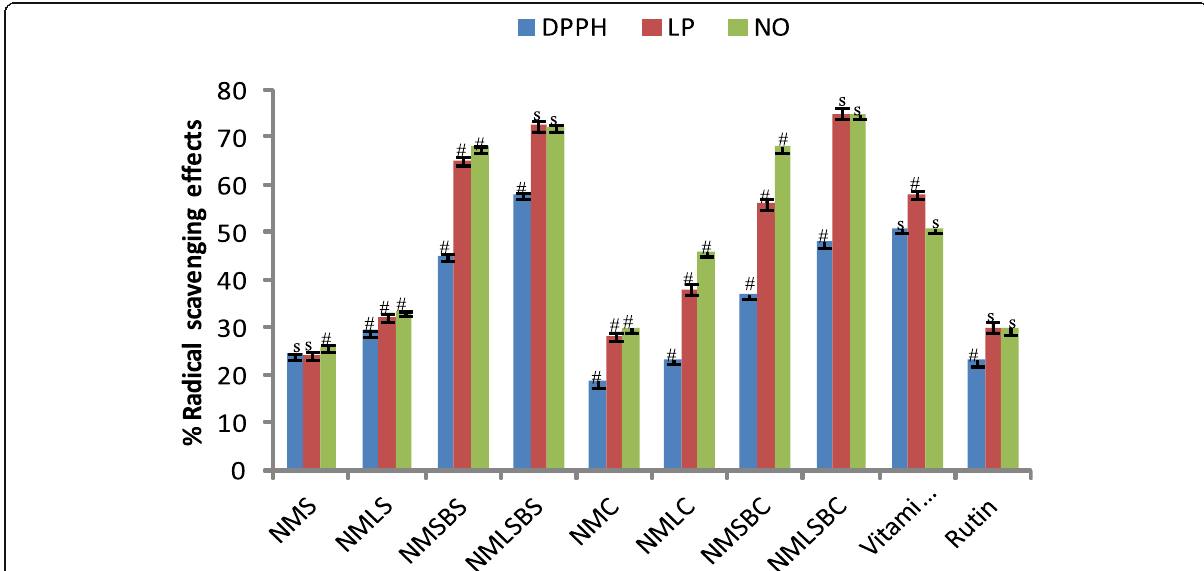
Fig. 2 Radical scavenging effects of neem cosmetics with and without secondary metabolites and reference compounds at 0.20mg/mL (#=significantly different, s=not significantly different p <0.05)